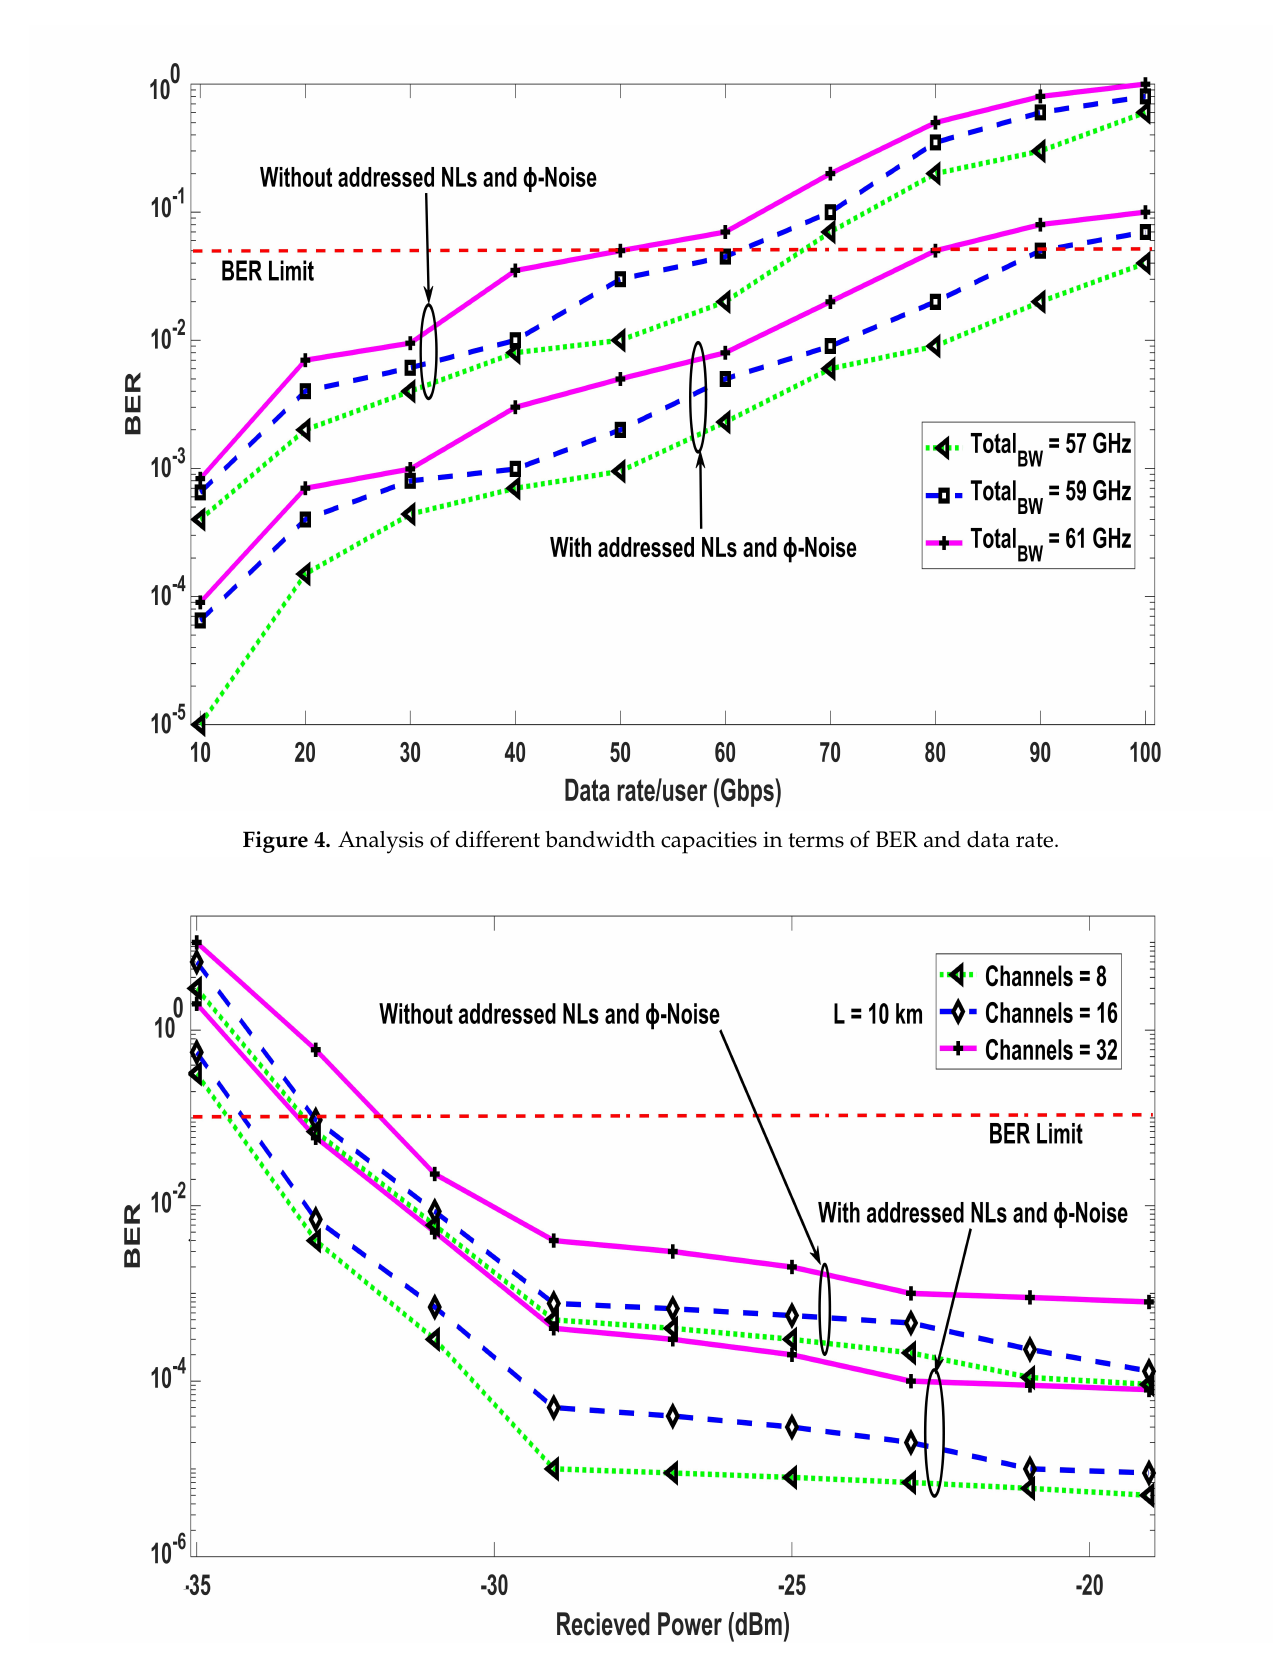
Figure 5. Received power vs. BER at 8, 16, and 32